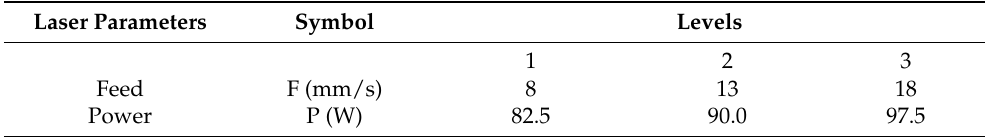
Table 1. LC parameters.